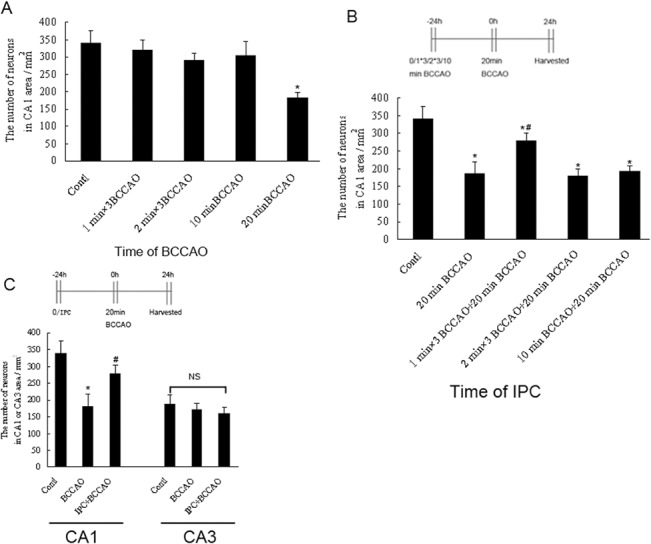
Determination of the lethal BCCAO time and the effects of IPC against lethal BCCAO in hippocampal CA1 neurons.(A) The effects of different types of BCCAO on survival of neurons in the hippocampal CA1 layer. Mice were exposed to several patterns of BCCAO followed by quantification of cell survival with Nissl staining 24 h later. (B) Different patterns of BCCAO protected CA1 neurons against 20 min of BCCAO. Mice were exposed to several patterns of sublethal BCCAO followed by 20 min lethal BCCAO 24 h later, and quantification of cell survival was carried out using Nissl staining 24 h later. (C) Comparison of the vulnerability of the CA1 and CA3 regions of the hippocampus to preconditioning. Values are given as the mean number of neurons. Error bars denote SDs. *P < 0.01 compared with the control group. #
P < 0.05 compared with other experimental groups.